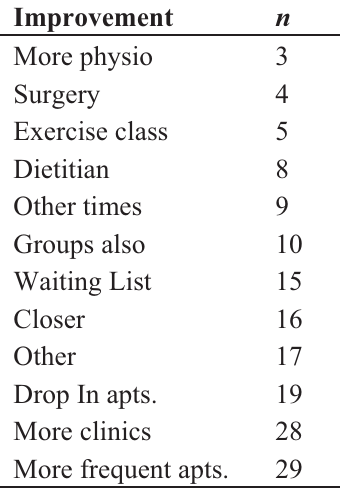
Figure 9. Number times each improvement was suggested. Table 18. Number of times each improvement was